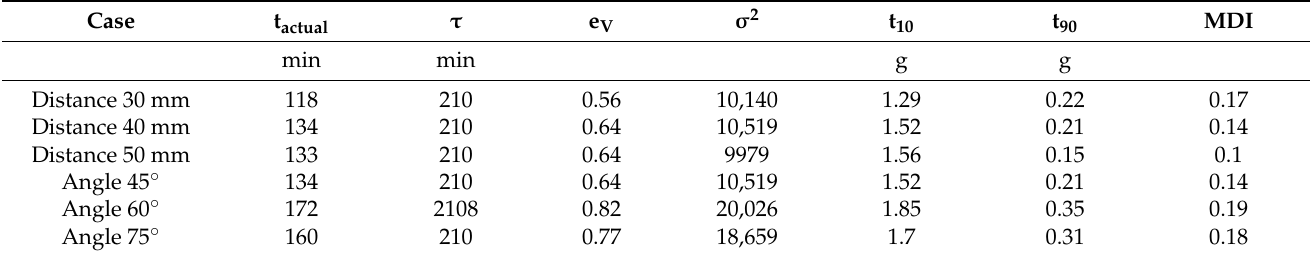
Figure 9. E(t) versus time tracer response curves obtained at the reactor outlet for different baffle angles ( a ) and different baffle distances ( b ). Table 2. Variation in hydraulic parameters of R3 under different baffle distances and